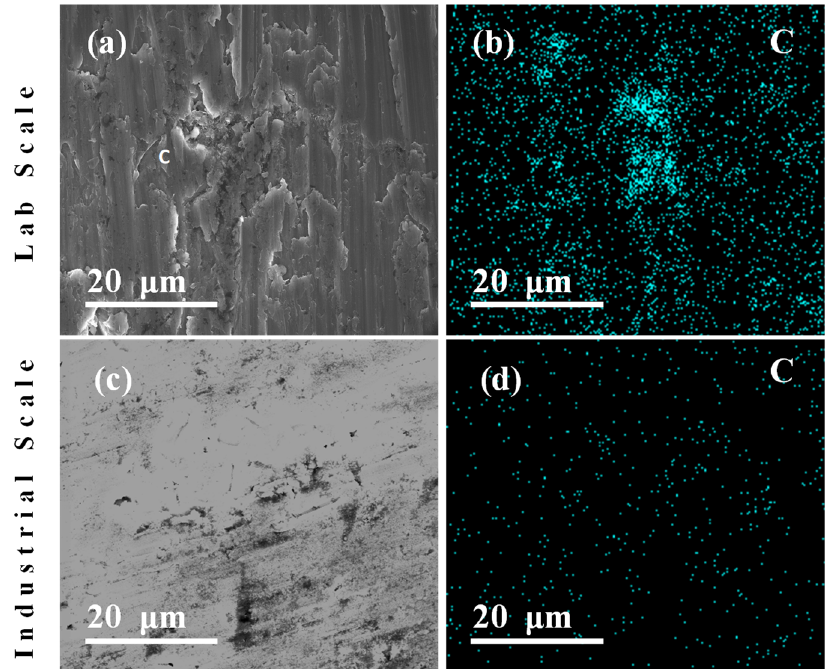
Figure 3. EDS-SEM micrographs for the analysis of carbon dispersion in the obtained sintered nanocomposite specimens. ( a , b ) Laboratory process and ( c , d ) Illustrates samples made from the industrial process that elucidate homogenous distribution through EDS-SEM elemental mapping carbon (C) analysis.